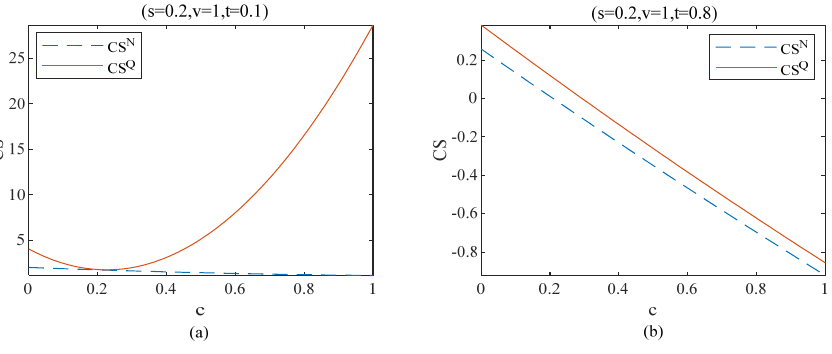
Figure 6. User surplus in equilibrium ( t = 0.1 vs. t = 0.8).